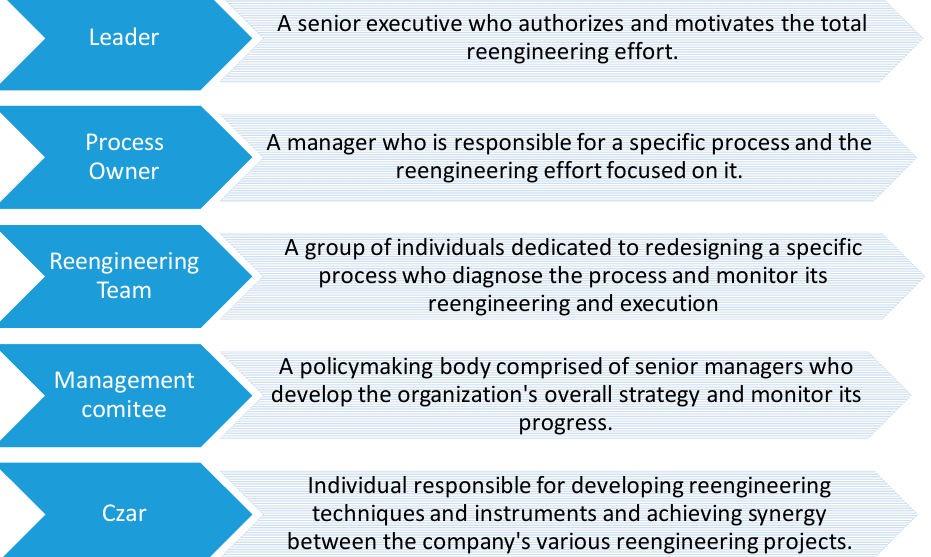
Table 1. Selection of the members of the reengineering team.